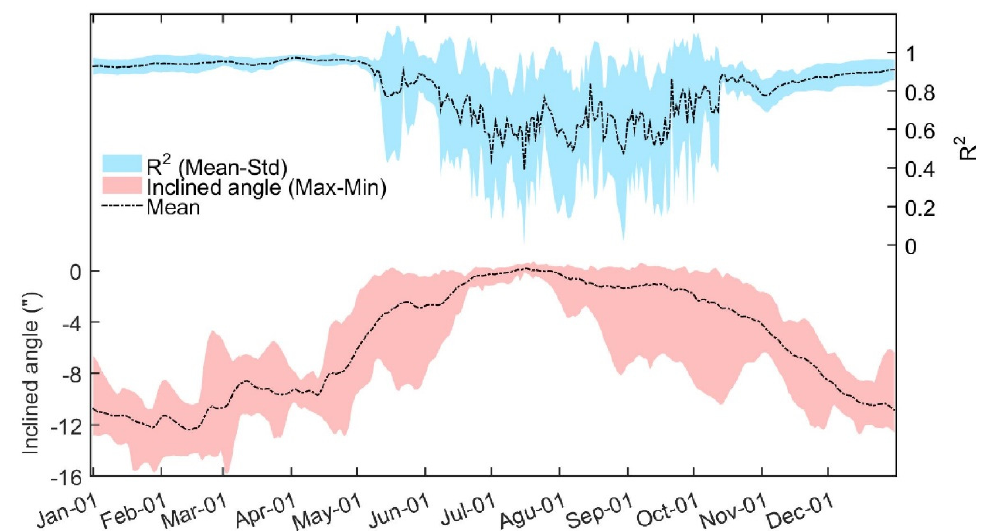
Figure 8. Daily changes of R 2 and inclined angles based on in situ measurements. The black dashed lines are the daily mean values of R 2 and inclined angles. The area in shallow blue shows the ranges of standard deviation, relative to the means. The area in pink shows the daily max and min ranges of the inclined angles, which were determined based on the linear relationship of the latitudes and daily measurements of the gauged stations.